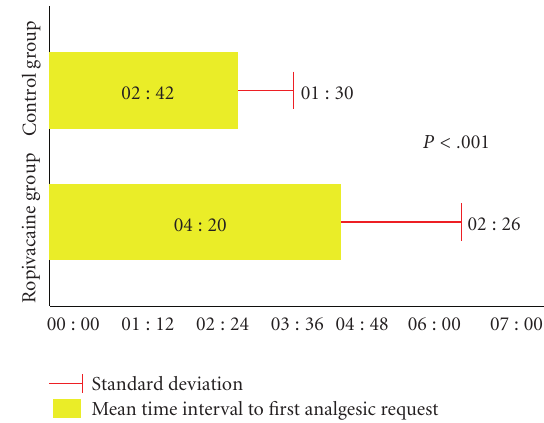
Figure 1: Interval before the first analgesic administration (Pain free